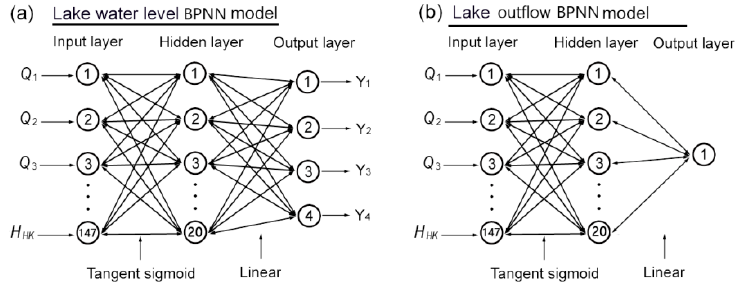
Figure 2. Structure of the two back-propagation neural network (BPNN) models. In the figure, Q means the daily discharge series from the six gauging stations of inflow rivers; H means the daily water level at Hankou station and Y means simulated lake water level at the four hydro-stations.